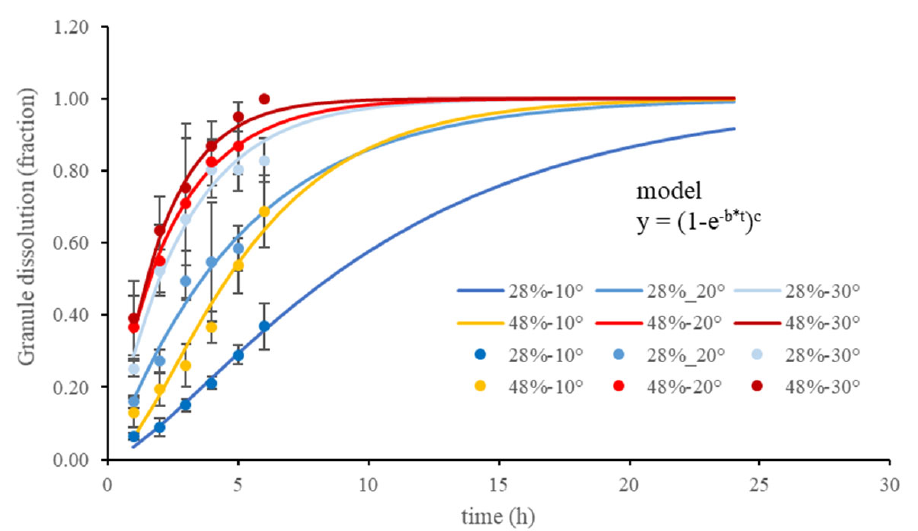
Figure 2. Urea granule dissolution rates and sigmoidal model fits at gravimetric soil moisture levels of 24% and 48%, and 3 temperature levels in a soil ‐ filled Petri dish incubated in a climate chamber (70% air humidity). Parameters are given in Table 1, error bars indicate standard deviation ( n = 4).